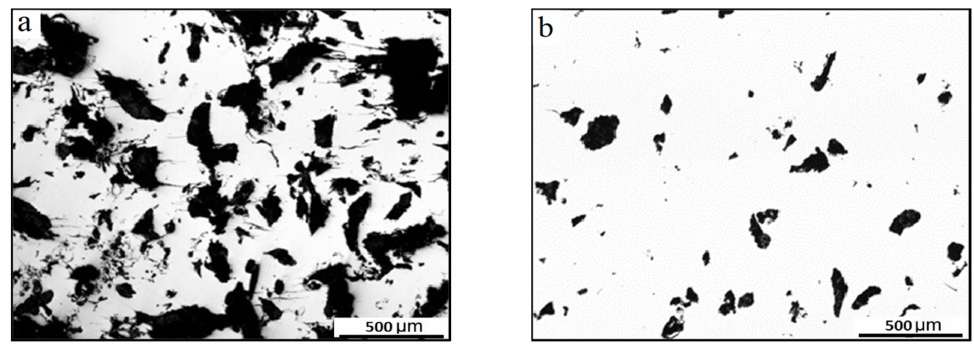
Figure 7. Surface metallographic photographs of corrosion fatigue formation of coated specimen: ( a ) 276 MPa after 100,000 cycles and ( b ) 552 MPa after 50,000